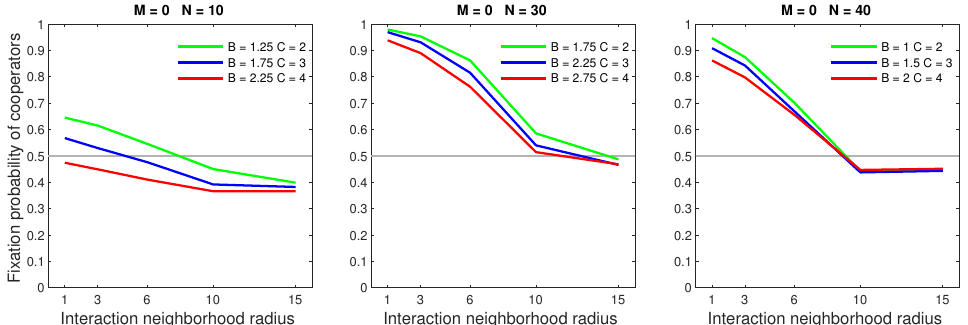
Figure 3. Increasing the cost of cooperation while maintaining the same relative benefits decreases the fixation probability of cooperators. The effects are greatest in sparse populations and populations with small interaction neighborhoods.